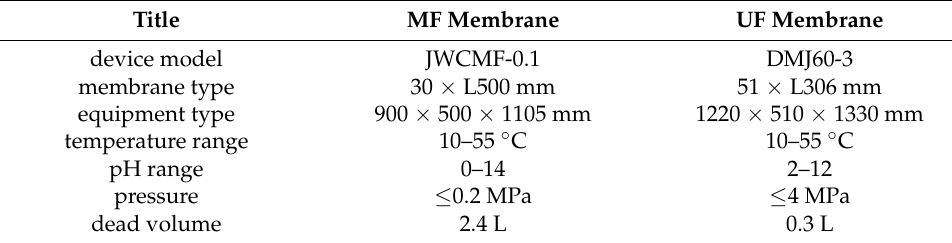
Table 1. Equipment parameters of ceramic membrane and organic